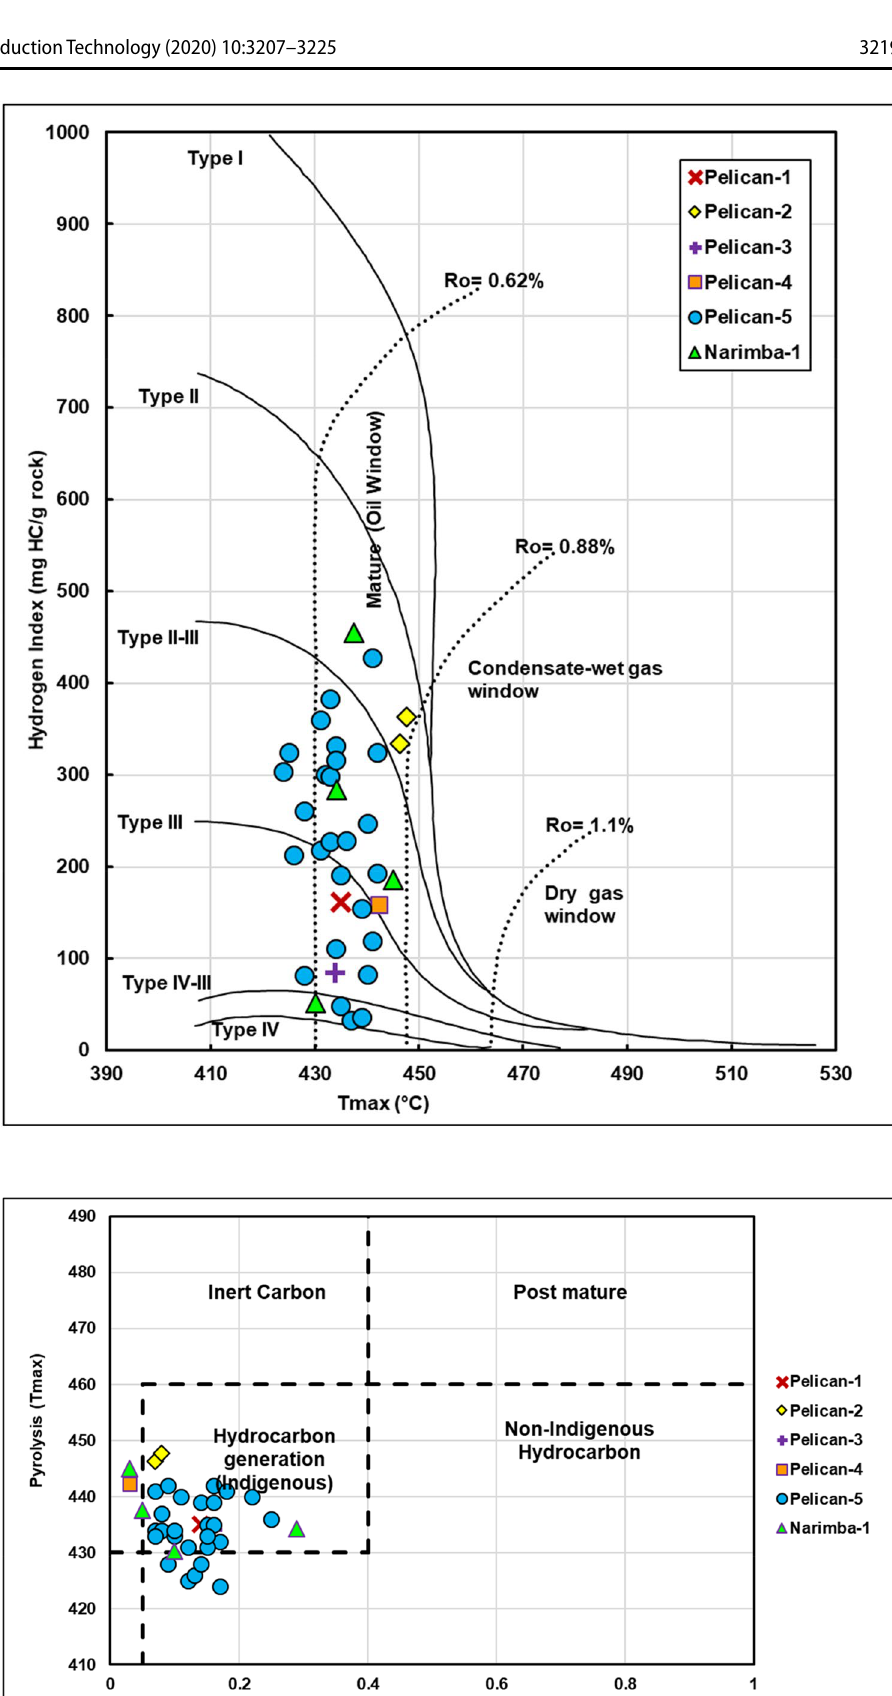
Fig. 10 Cross-plotting HI versus T max to indicate source rock thermal maturity